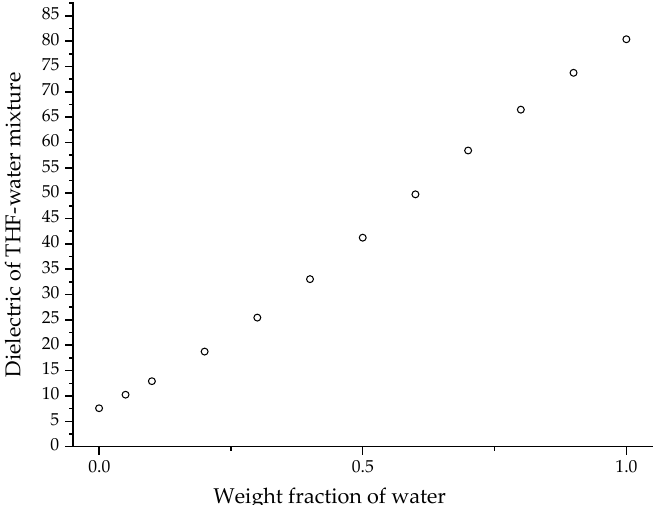
Figure 3. Dielectric of water/THF mixture. Data taken from [7].